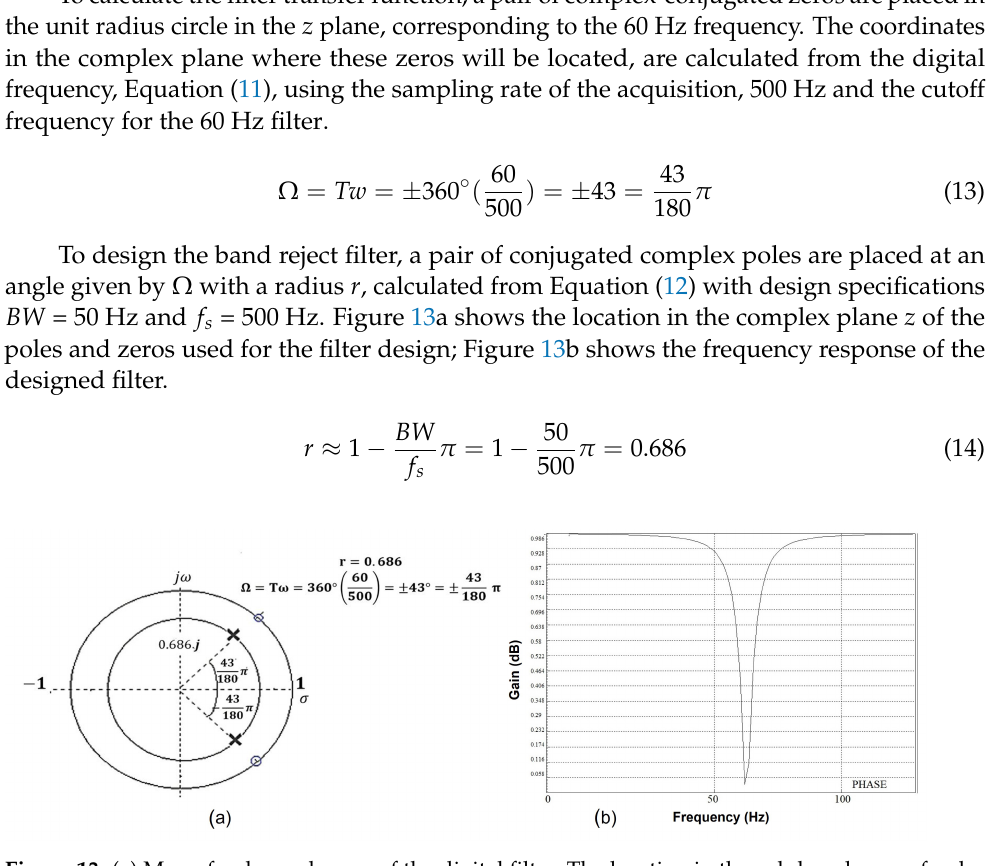
Figure 13. ( a ) Map of poles and zeros of the digital filter. The location in the colplex plane z of poles and zeros for the filter design. ( b ) Notch digital filter phase diagram. Frequency response of the designed